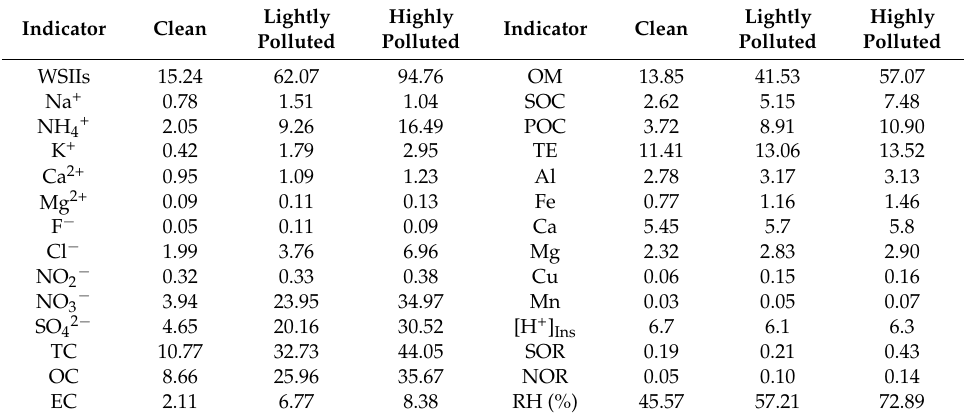
Table 2. PM 2.5 chemical composition characteristics at different pollution levels of PM 2.5